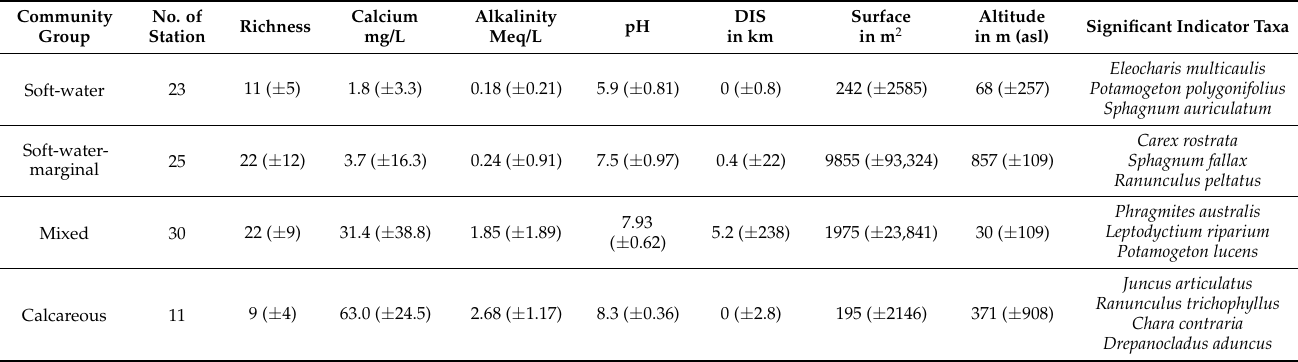
Figure 2. Community group partition. Ward’s minimum variance cluster analysis based on Square- rooted Bray–Curtis matrix from abundance-classes taxonomic composition at 89 sites sampled between 2013–2018. Groups are labelled according to variables identified by Dunn’s test (alkalinity, calcium, pH). Table 1. Floristic community group characteristics and their respective median values ( ± SD). Best indicator taxa are noticed for each biological form (helophyte, hydrophyte, Characeae, and bryophyte). Complete list of indicator taxa and corresponding index values (specificity, fidelity, indicator value) are noted in Table S2. asl = above sea level. DIS = distance from source.